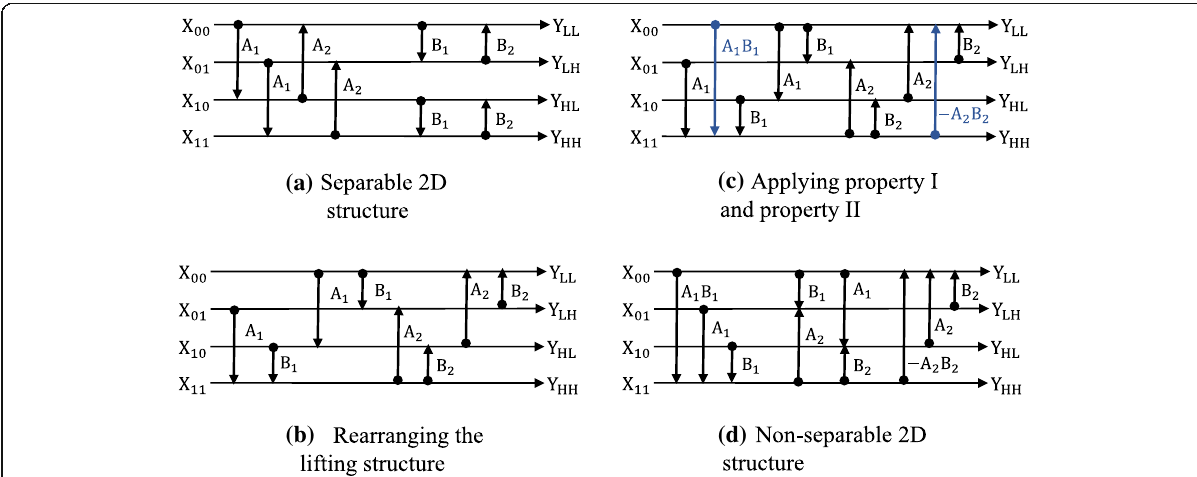
Fig. 9 Derivation process for non-separable double-lifting 2D structure. a Separable 2D structure. b Rearranging the lifting structure. c Applying property I and property II. d Non-separable 2D